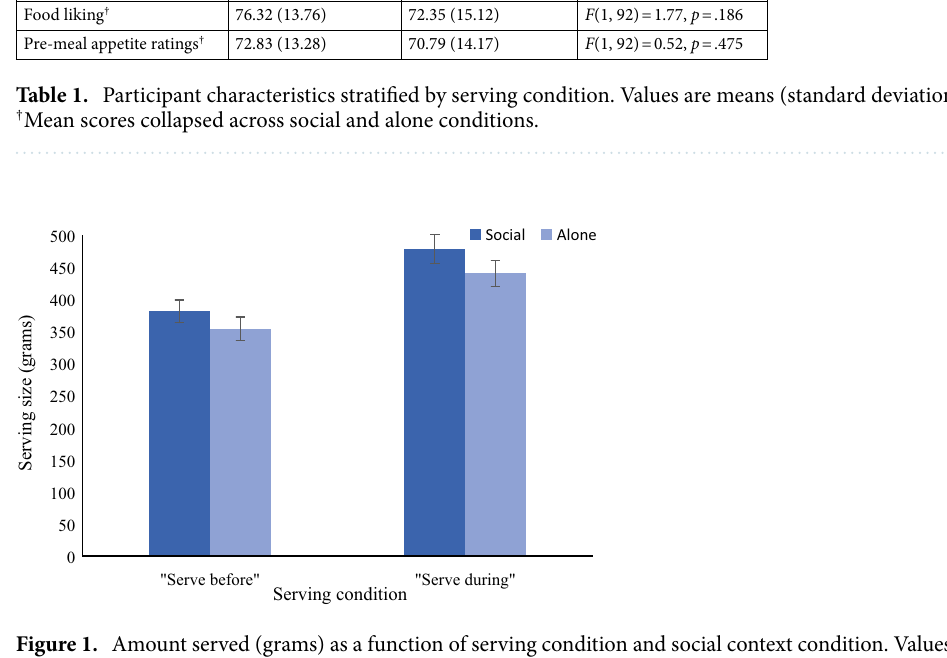
Figure 1. Amount served (grams) as a function of serving condition and social context condition. Values are means, and error bars represent the standard error of the